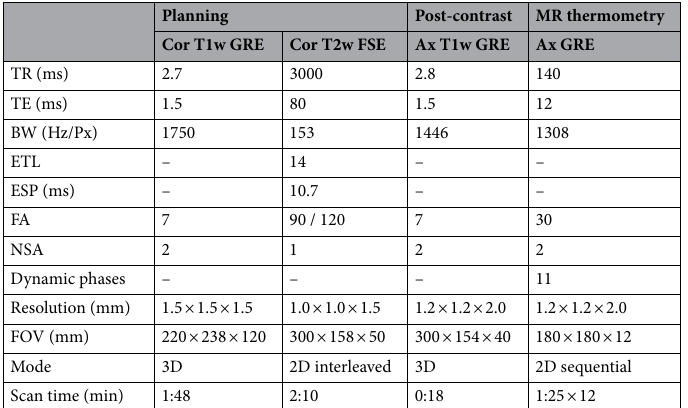
Table 1. MRI sequence parameters. All sequences used the 2-channel window coil. Axial images used LR phase encoding to avoid wrap artifacts from the oil tank housing the ultrasound